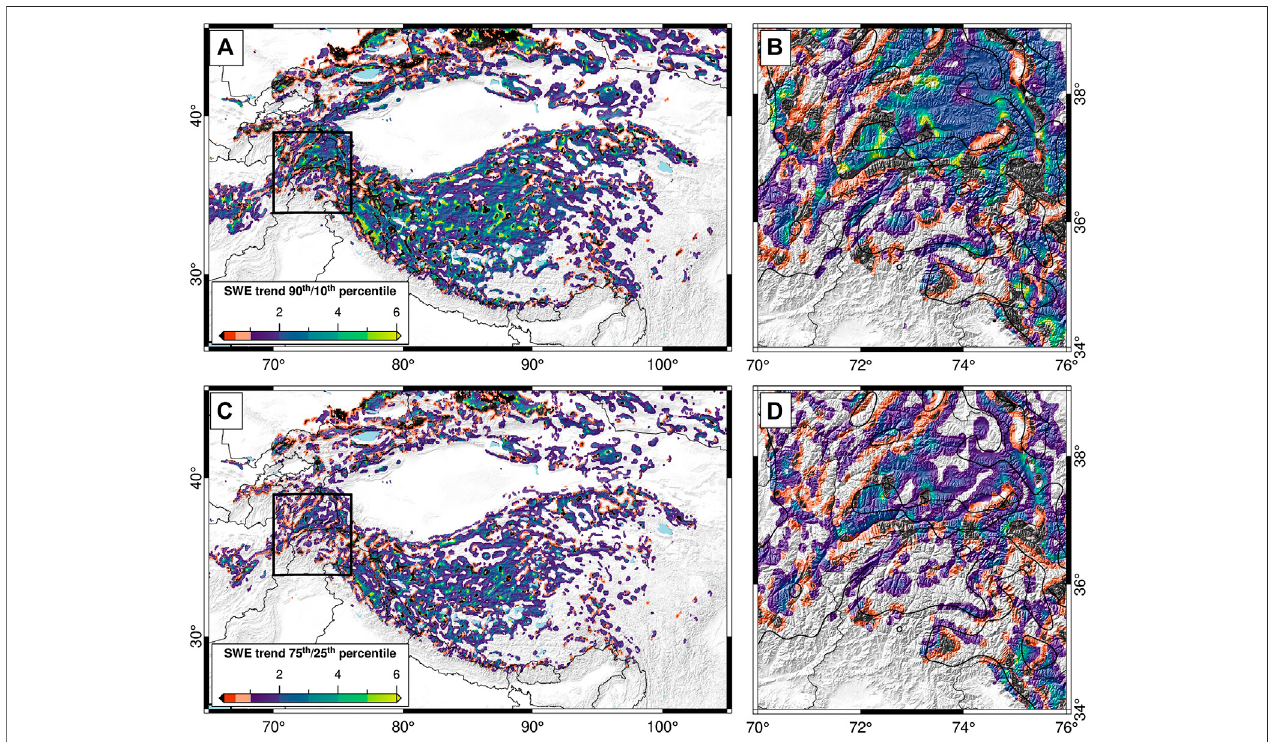
FIGURE6| Ratios oftrendsin (A,B) 90th/10th percentile snow-waterequivalent (SWE)and (C,D) 75th/25th percentileSWE. Panels (B,D) showzoom inboxover the Karakoram, with 100 mm average December-January-February SWE contour line in thick black. Positive (e.g., blue to green) values indicate that the trend in 90th (75th)percentileSWEvaluesislargerthanthetrendin10th(25th)percentileSWEvalues,andthatbothtrendshavethesamedirection.Orangeandredareashavehigher 10th (25th) percentile trends than 90th (75th). Black areas indicate a reversal of trend between the 90th/10th (75th/25th) percentiles. The vast majority of High Mountain Asia — in both positive and negative SWE trend areas (see Figure 3 ) — has steeper trends in high-percentile SWE than in low-percentile SWE.